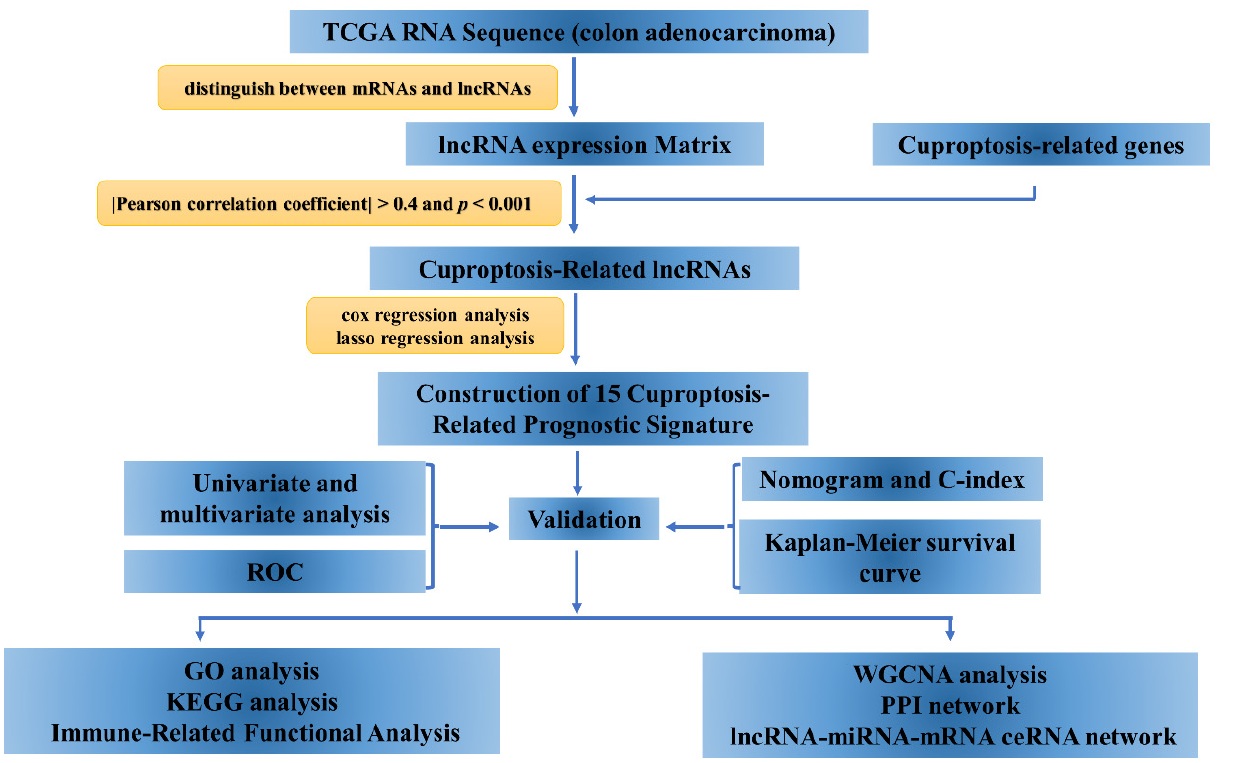
Figure 1. The flow chart diagram of the study.